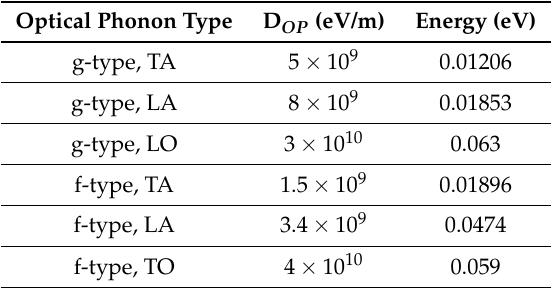
Table 5. Deformation potential (D OP ) and energy considered for the different branches in the optical scattering mechanism.